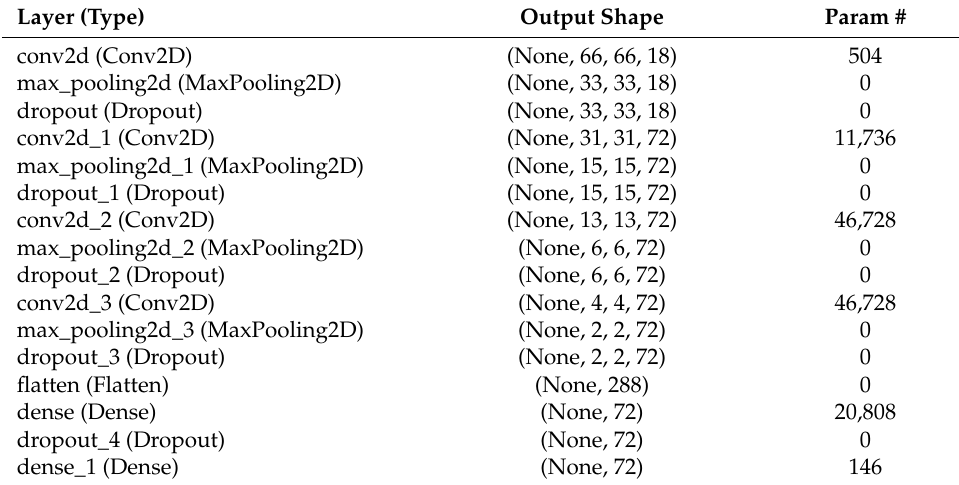
Table 1. Convolutional neural Network model summary.